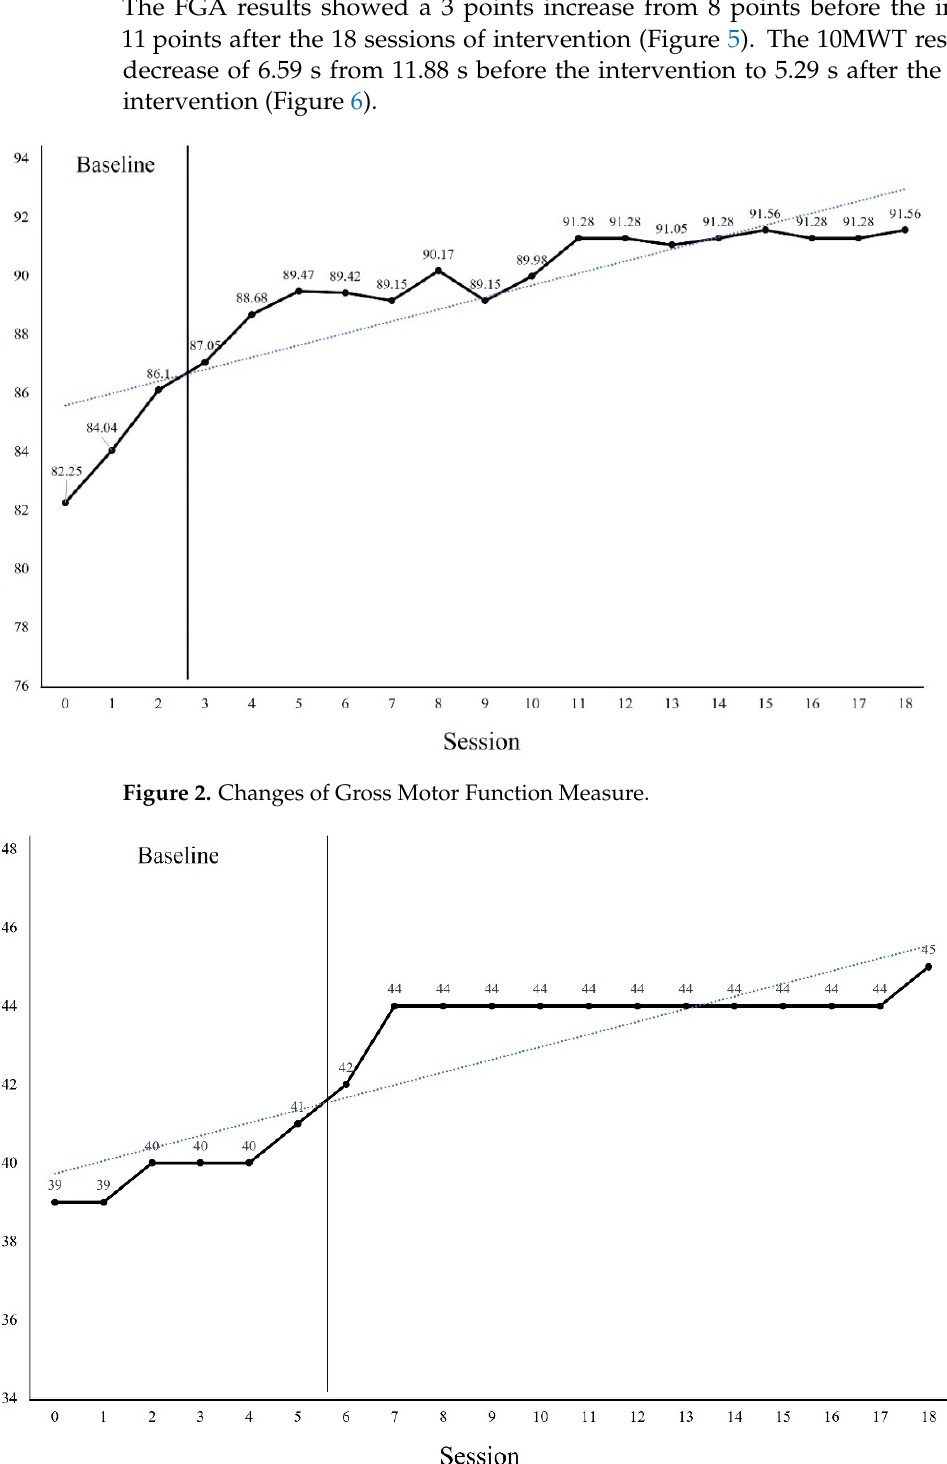
Figure 3. Changes of Pediatric Balance Scale.